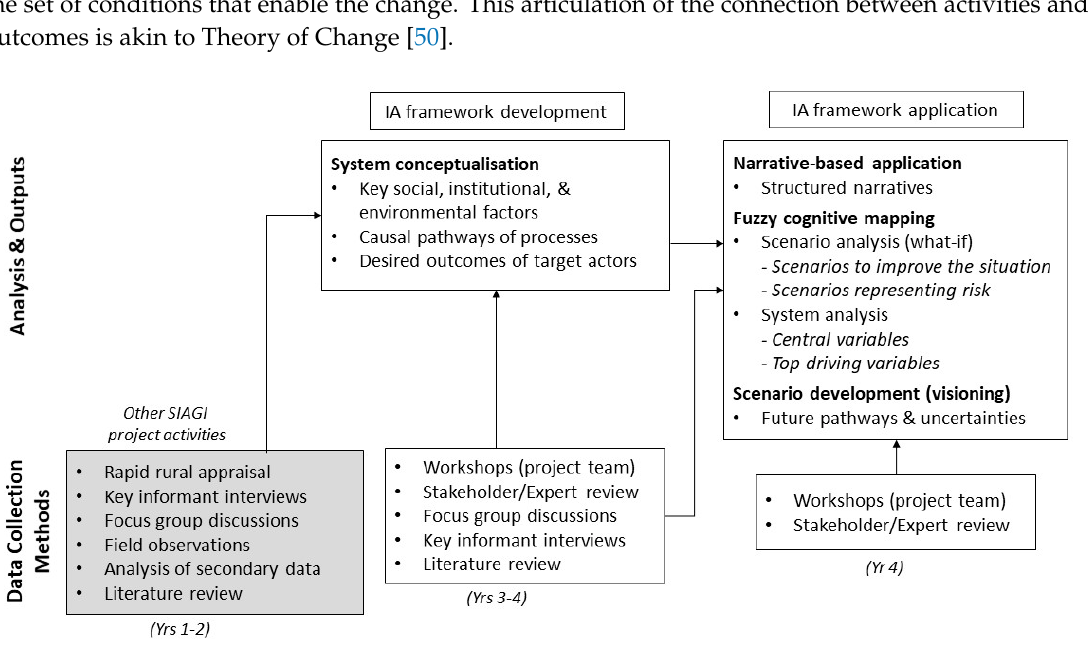
Figure 2. Overview of the integrated assessment (IA) framework development and application methodology, including the data collection methods used and their input to the various analyses and outputs, and the approximate timeline of activities within the 4-year project.